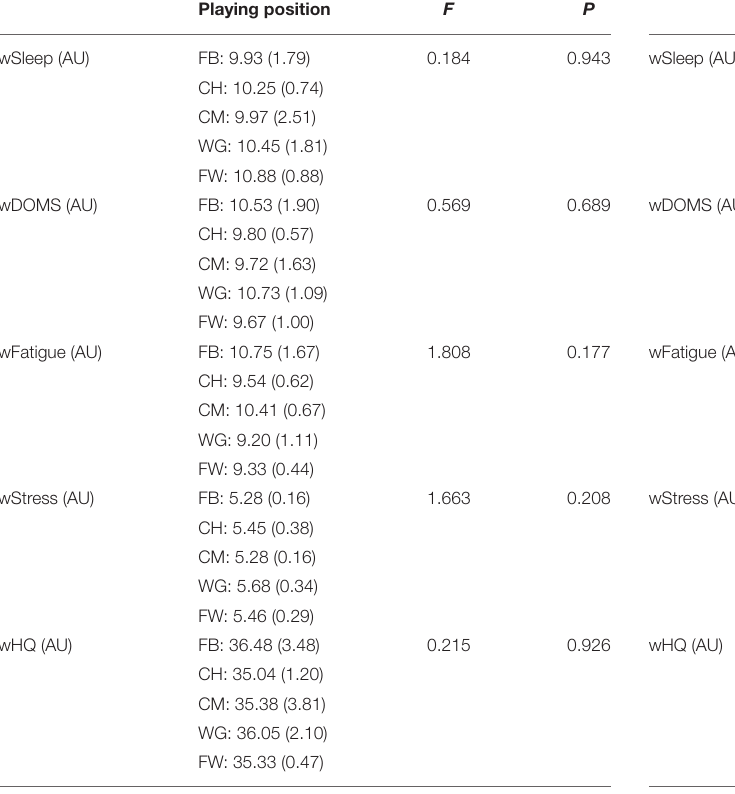
TABLE 4 | Outcomes of ANOVA for well-being variables during mid-season, considering playing positions. Playing position F P wSleep (AU)